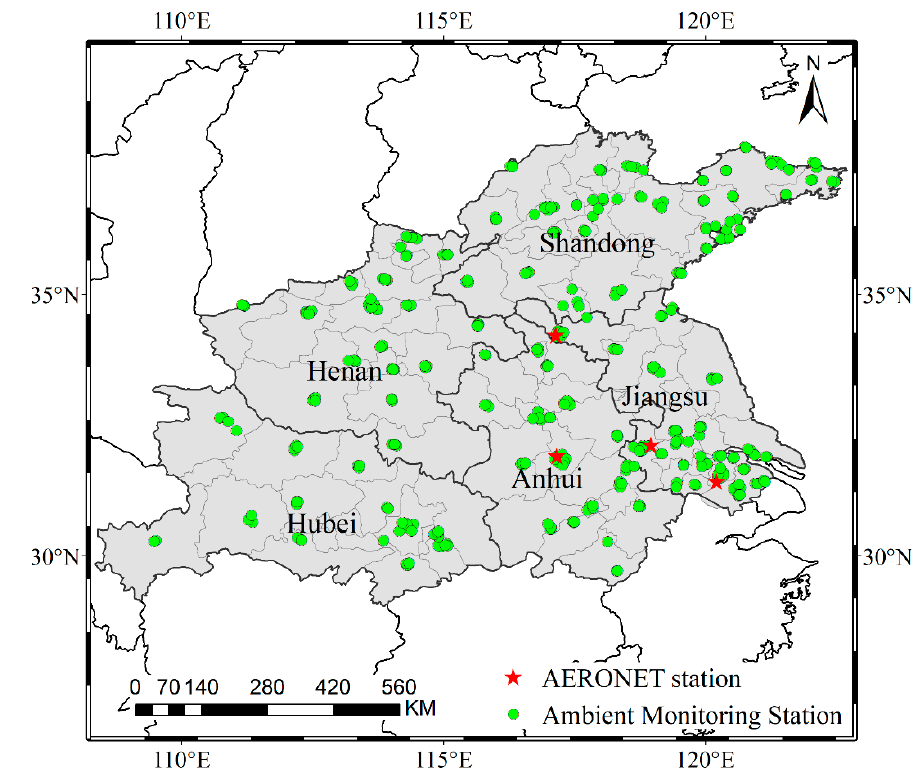
Figure 1. Study area and station location.